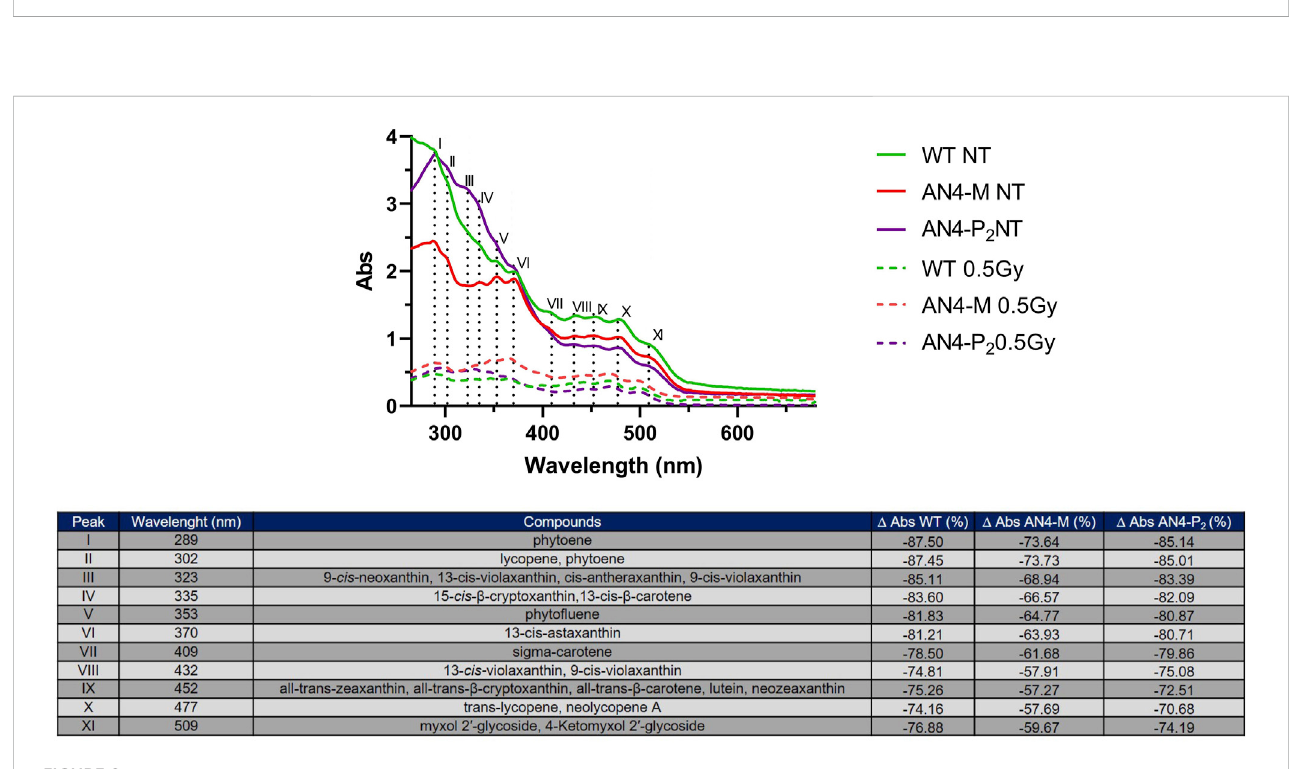
Frontiers in Astronomy and Space